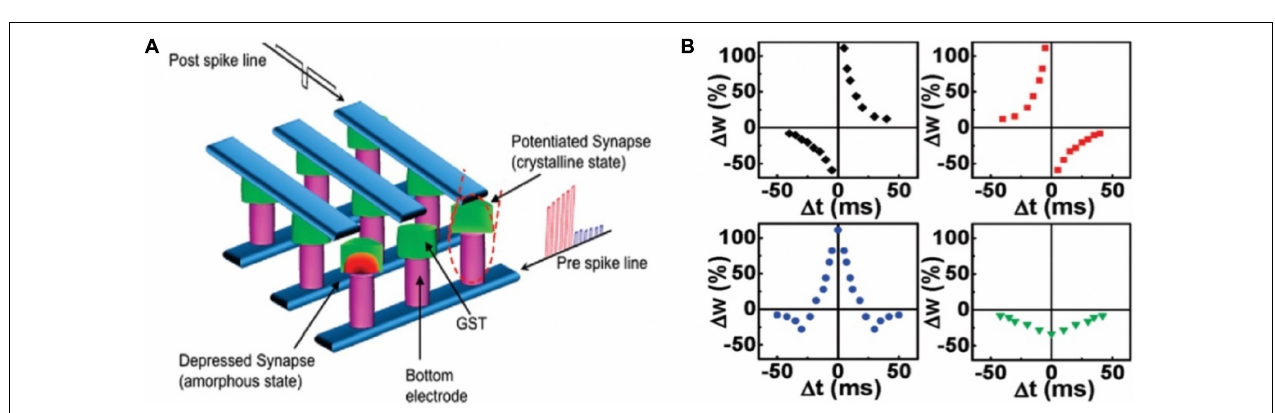
FIGURE 4 | (A) Schematic diagram of the crossbar array architecture of the PCM synapses. (B) Different forms of STDP learning rules (adapted from Kuzum et al., 2012).